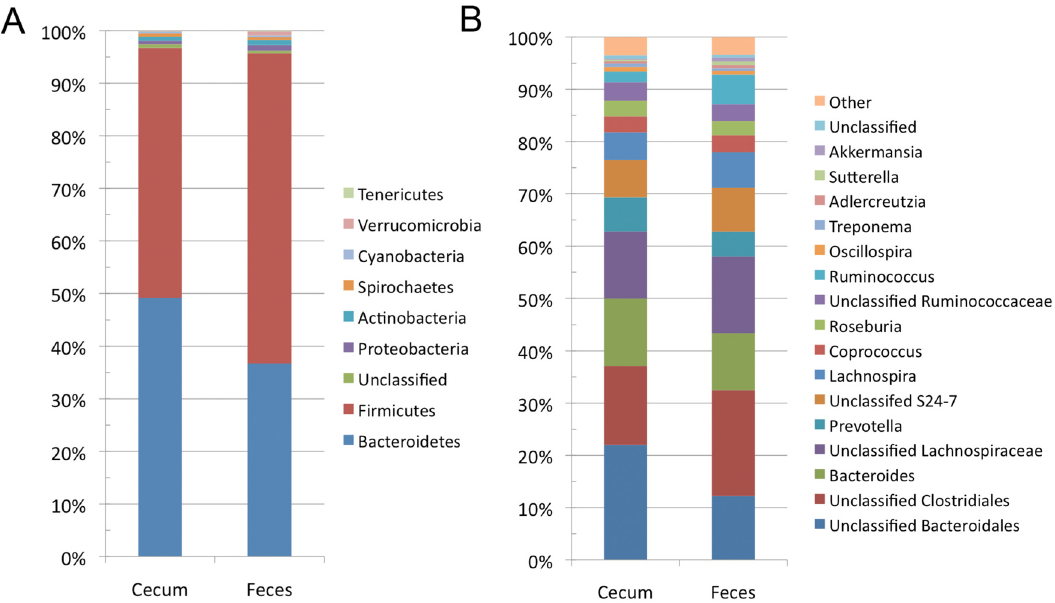
Fig 3. Average taxonomic summary of the bacteria identified in the ceacum and feaces of beavers at both the phylum and genus level. A) Average relative abundance of sequences in all ceacum and feaces samples at the phylum level. B) Average relative abundance of sequences in all ceacum and feaces samples at the genus level. Sequences present with < 0.5% relative abundance were pooled into a group labeled “ other ” .